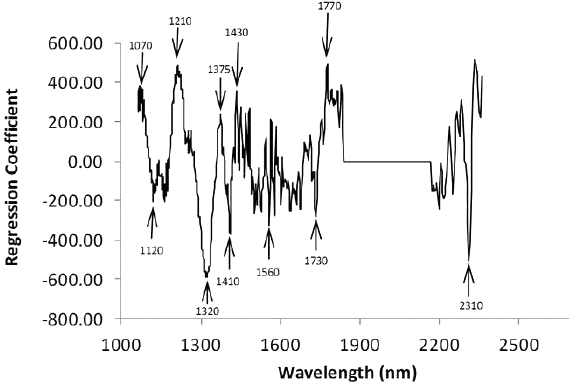
Fig. 7. Regression coe±cient plot of milled Hommali rice.